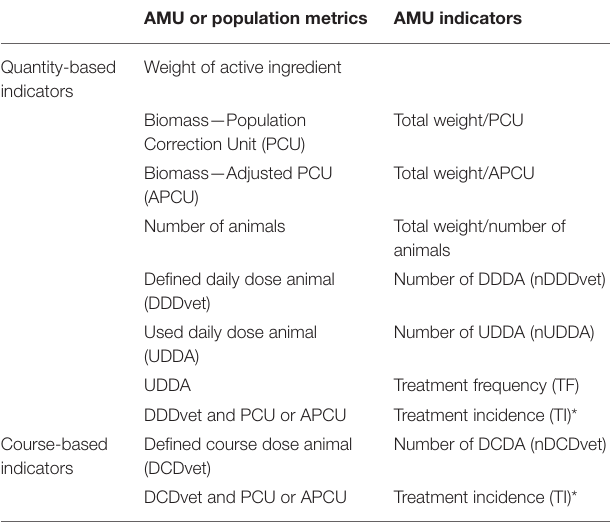
TABLE 1 | Examples of antimicrobial use (AMU) surveillance indicators linked to underlying AMU and population